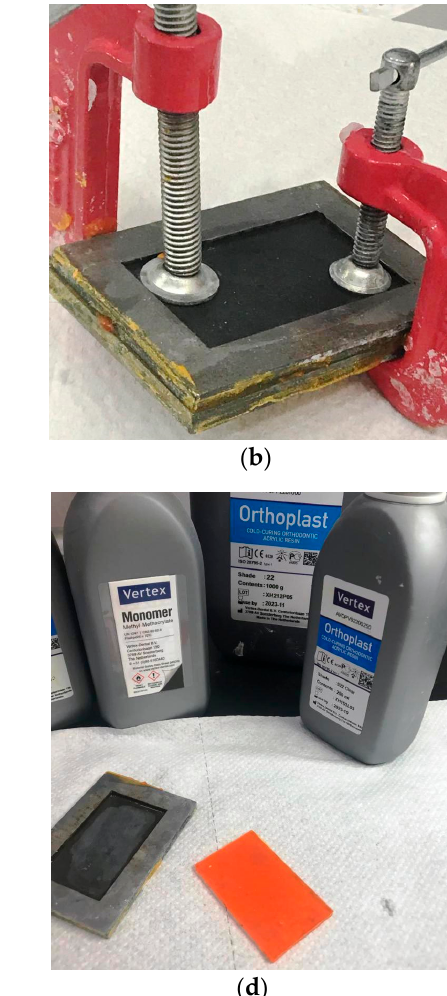
Figure 3. SEM micrographs of the surface of the tested materials (mag. 1000×). 2.3. Flexural Strength and Flexural Modulus In this work, the bending strength test consisted of conducting a three-point bending test which is experimental modelling [48]. The test is carried out according to a codified method included in the ISO 178 technical standard [49]. The samples used in the study were made as cuboid orthodontic plates (OP) with nominal dimensions of: width b = 30 mm, thickness d = 2.5 mm, and length l = 50 mm. 15 samples of each material were made. The thickness (height) and width of the specimens were measured with a dial caliper. The specimens were aging in an artificial saliva bath at 37 ± 1 °C. The